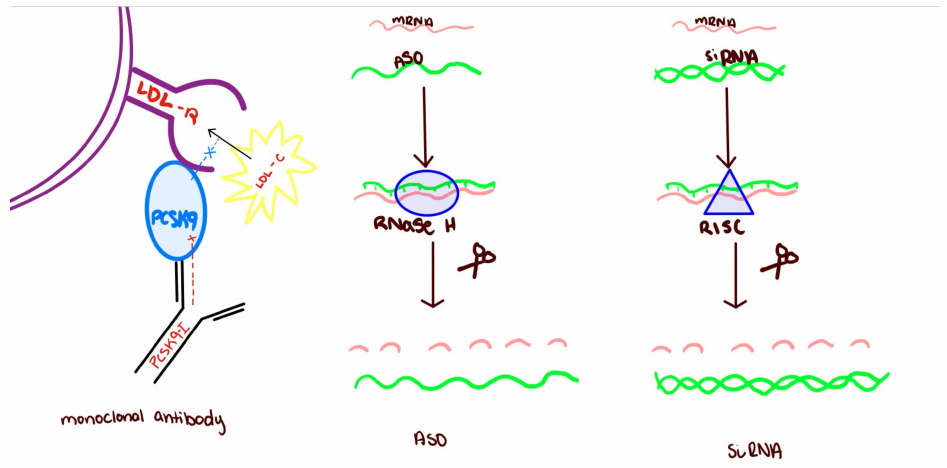
Figure 1. Mechanism of action of monoclonal antibodies and gene silencing